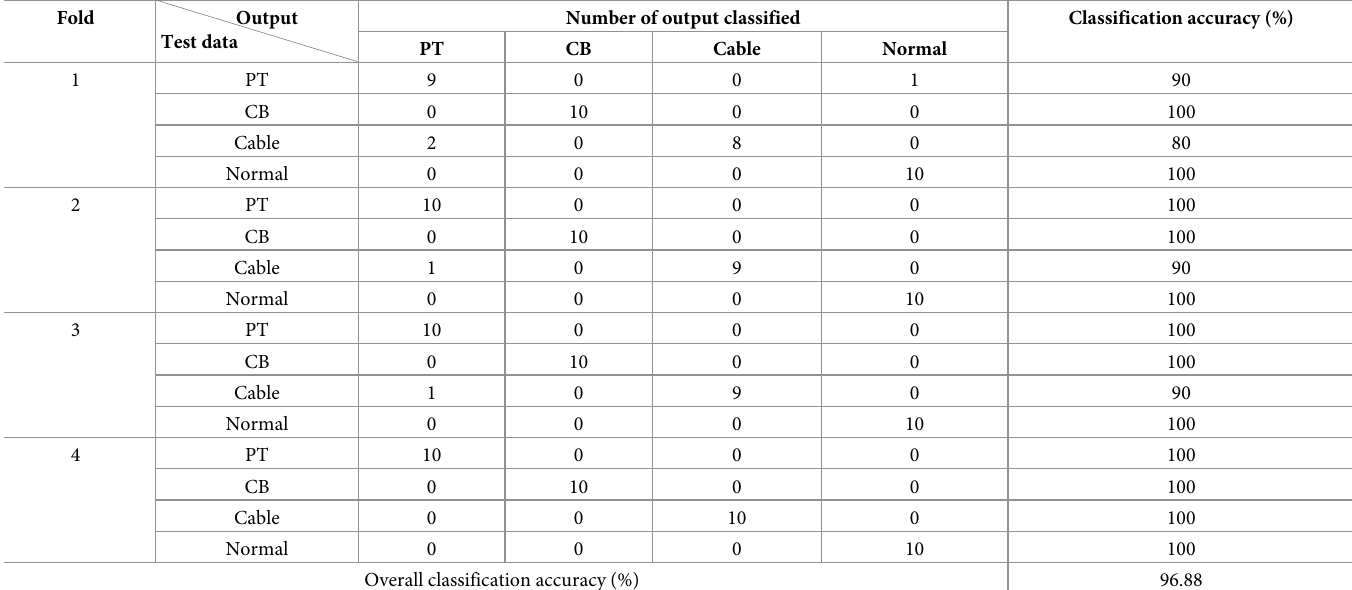
Table 9. Classification results using GSA-SVM based on 4-fold cross validation.